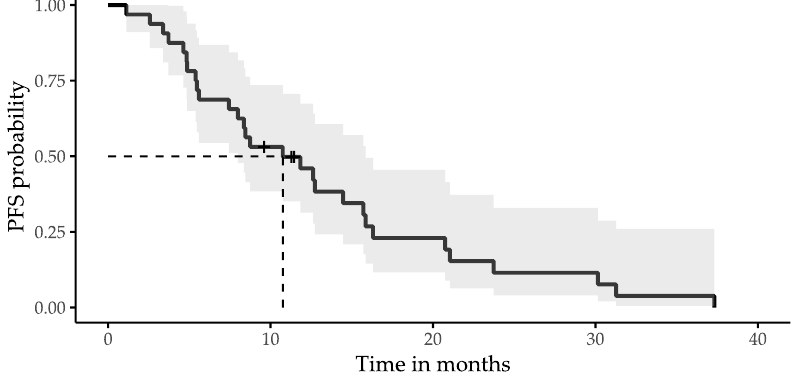
Figure 2. Kaplan–Meier curve of PFS after salvage PRRT with 95% CI. Censored subjects are indicated as tick marks. The median PFS equals 10.8 months (95% CI: 8.0–15.9 months). In univariable Cox regression, a higher De Ritis ratio (hazard ratio (HR): 2.64, 95%